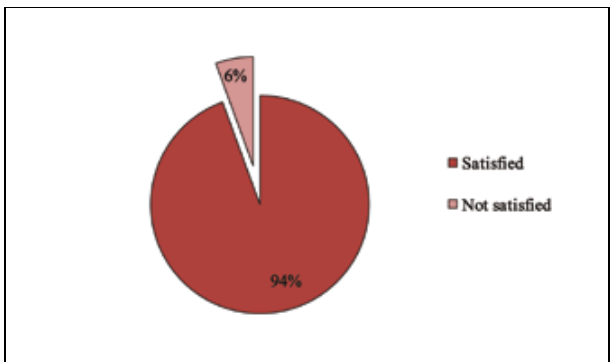
Figure 7. Total satisfaction (%) among participants